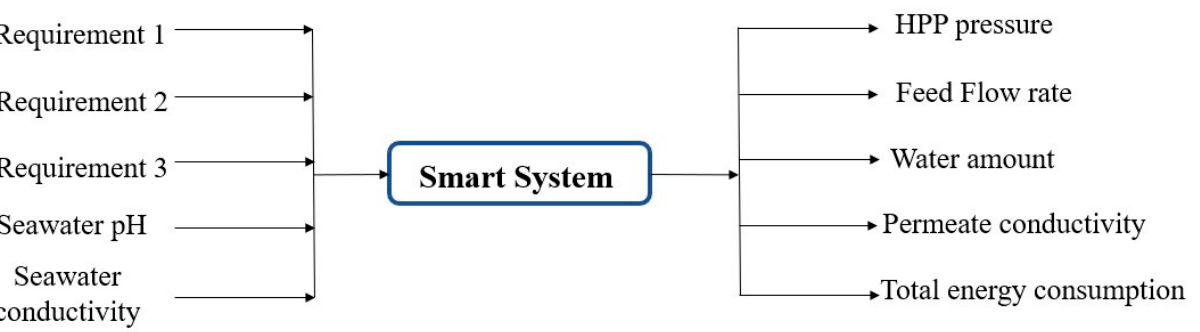
Figure 7. Block diagram of the “Smart System” function.